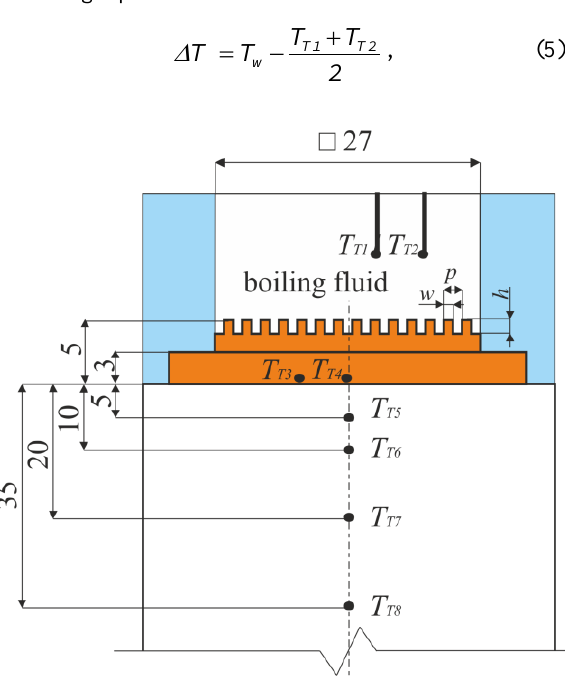
Fig. 2. Arrangemet of